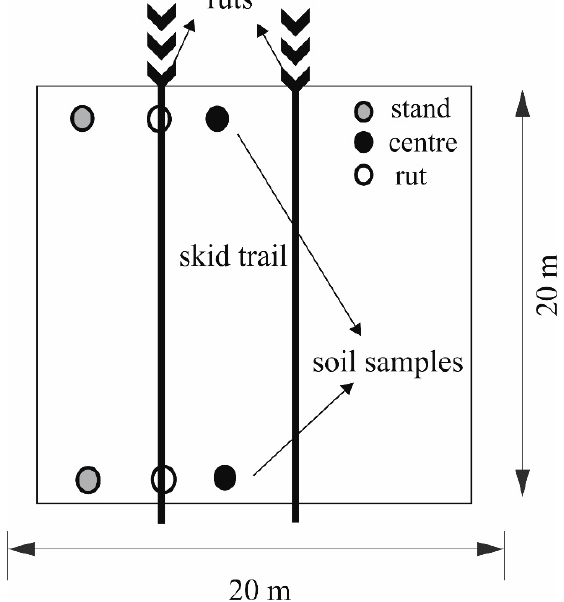
Figure 2. Shape and dimensions of sample plots, and location of soil sampling points (stand, centre = space between ruts, ruts). Table 3. Classification of damage location on the tree [29].